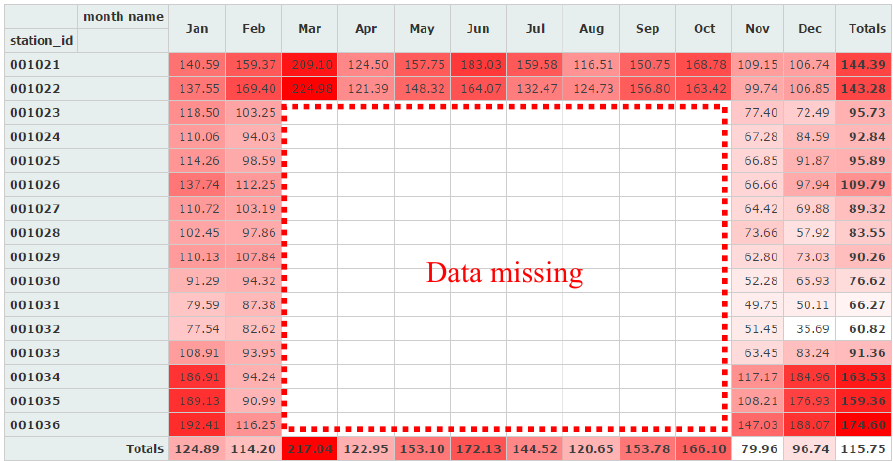
Figure 3. Missing data identified through an organized table.